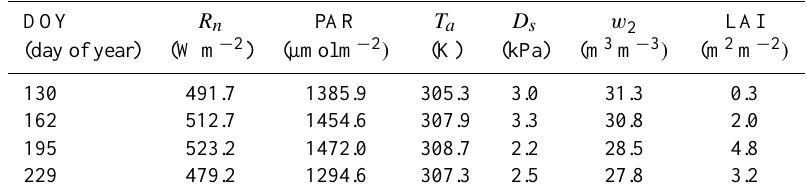
Table 2. Mean daytime meteorological and ecological elements on selected days. DOY R n